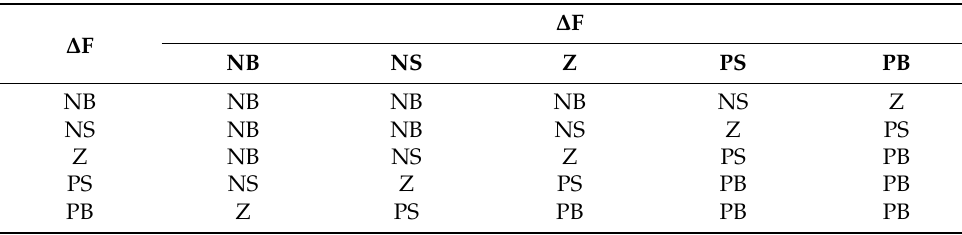
Table 3. Fuzzy rule base of the proposed